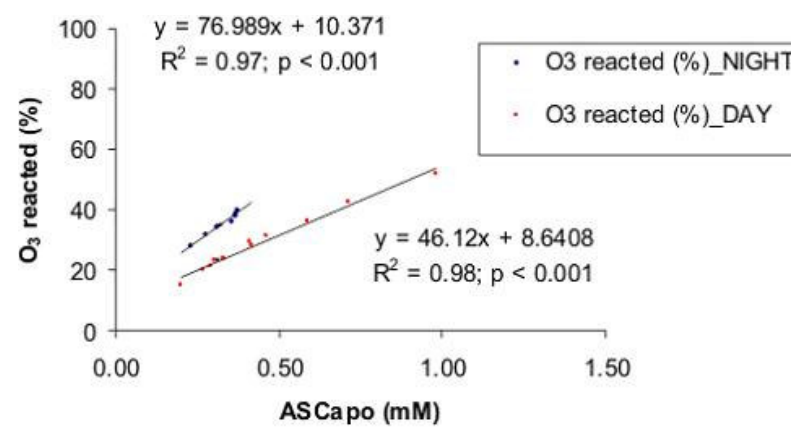
FIGURE 6. Regression for ozone reacted (O 3 reacted) and reduced apoplastic ascorbic acid (ASC